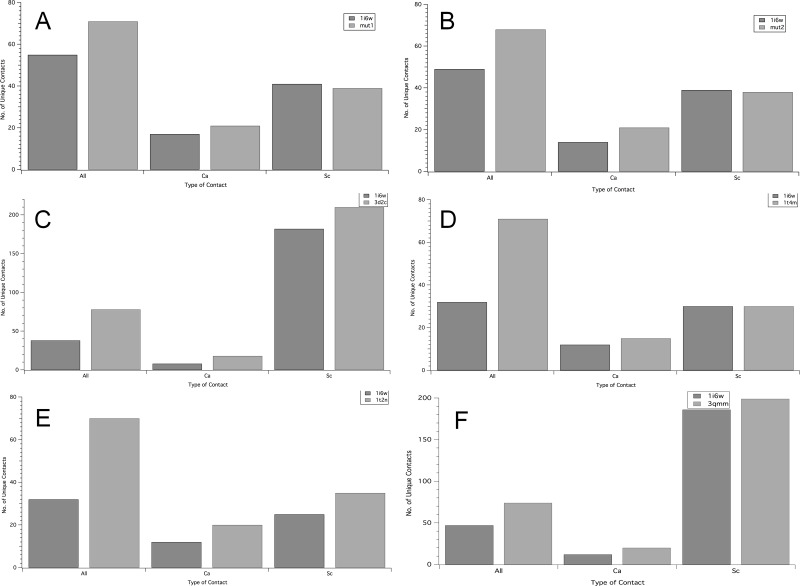
Comparative bar graphs of unique contacts in thermostable mutants of Bacillus subtilis lipase and wild type (1i6w).A 1i6w vs. 1t2n; B 1i6w vs. 1t4n; C 1i6w vs. 3d2c; D 1i6w vs. 3qmm; E 1i6w vs. mut 1; F 1i6w vs. mut 2. All represents all unique contacts in PDB structure, ca represents backbone unique contacts and sc represents side chain unique contacts.